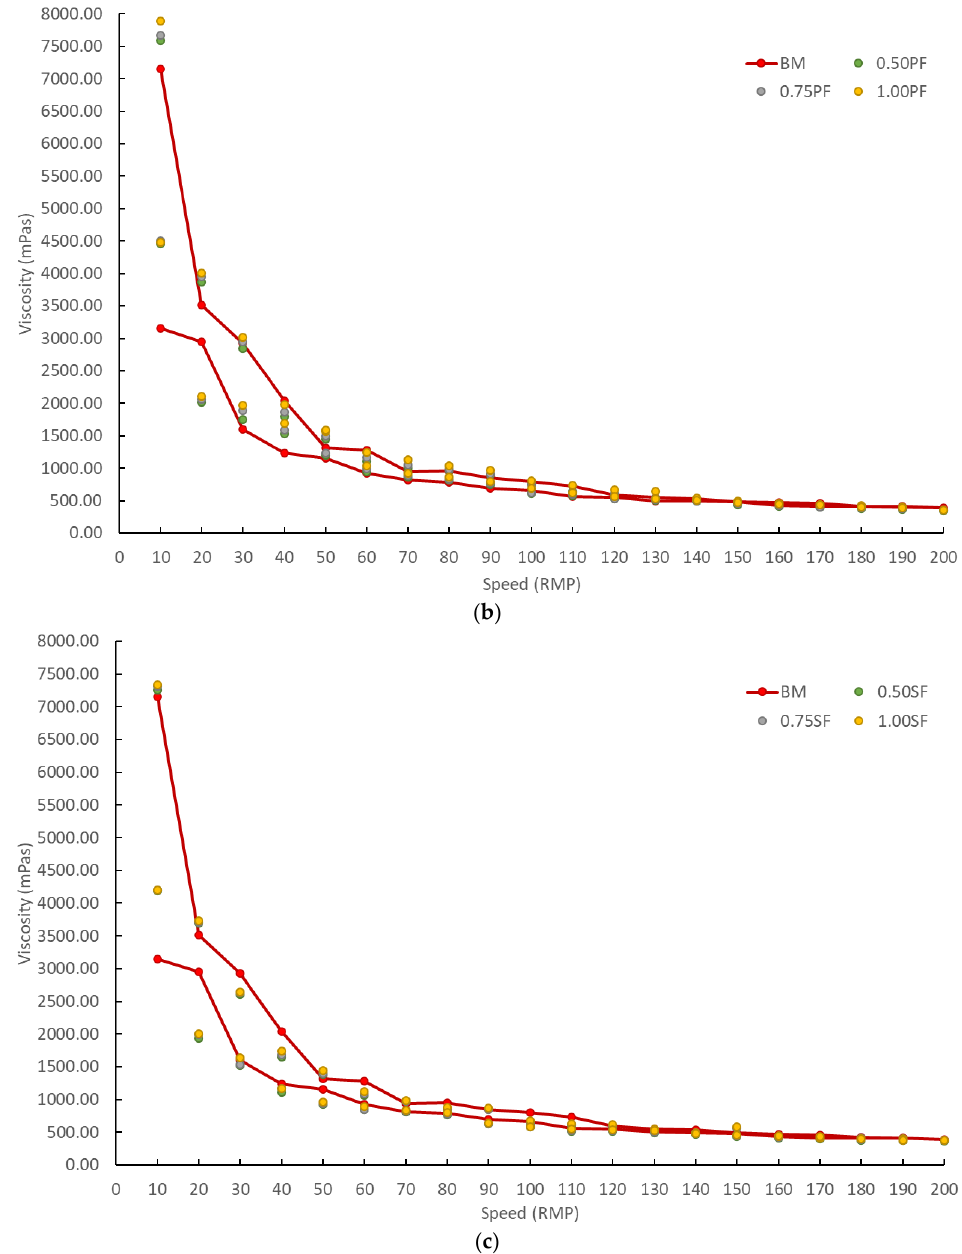
Figure 5. Viscosity test results of the tested mixtures: ( a ) glass fiber concretes; ( b ) polypropylene fiber concretes; ( c ) steel fiber concretes.